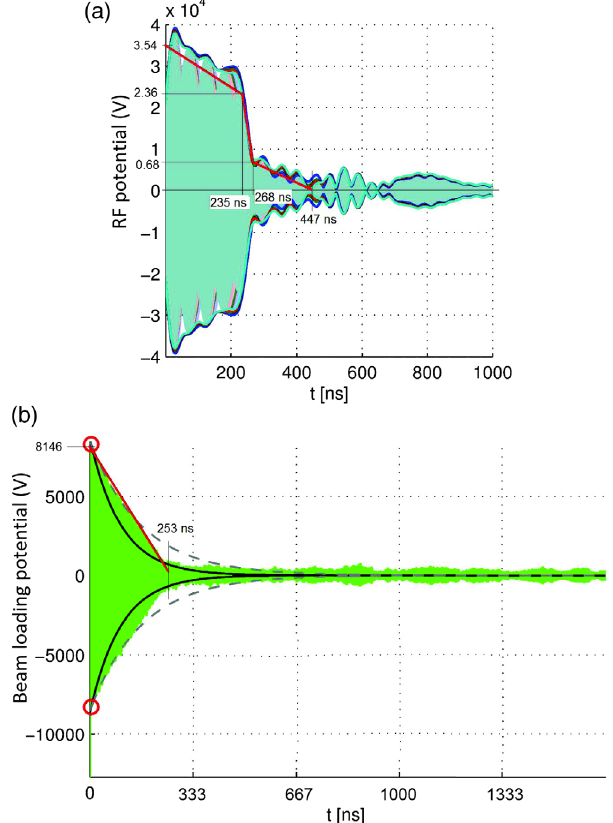
FIG. 5. Simulation results for rf filling potential (a) and beam loading amplitude (b) as functions of time for the CLIC drive beam cavities [2]. The approximations with linear functions are indicated by the solid red lines. In (b) two exponential approx- imations are indicated by the black solid and dashed lines.